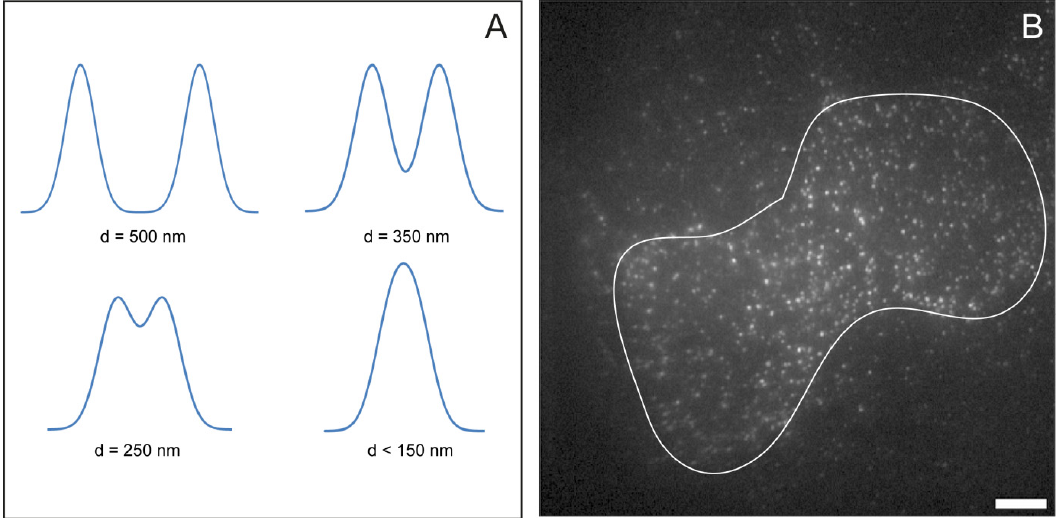
Figure 1. ( A ) Simulated intensity cross sections through a pair of single molecule fluorescence emitters with varying separations. Individual features can only be resolved when the molecules are separated by a distance greater than the point spread function of the microscope; ( B ) Single molecule TIRF image of EGFR in the plasma membrane of HeLa cells (expressing approximately 50,000 EGFR molecules per cell). EGFR are labelled with their ligand EGF, conjugated with the fluorophore Atto 647N (bar 8 µm). The white line shows the approximate cell